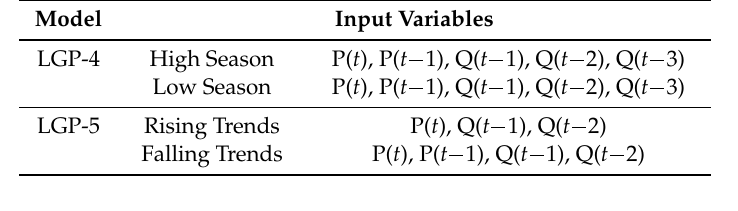
Table 2. Input variables for LGP as standalone application in capturing different aspects of hydrograph.